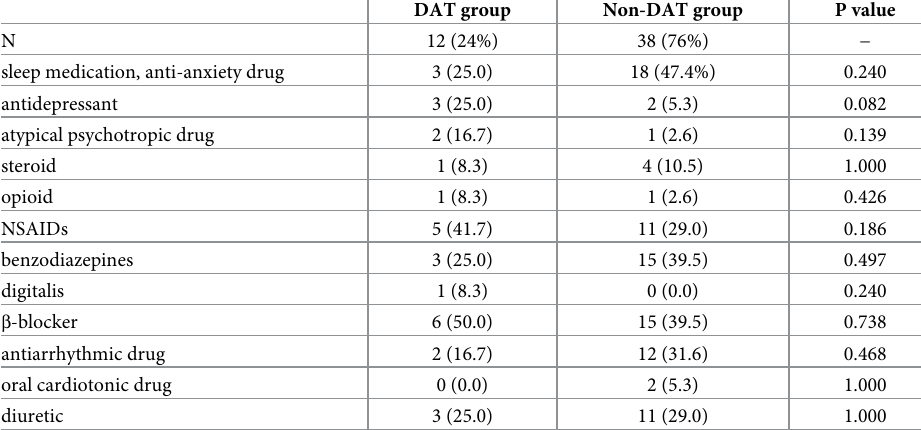
Table 2. Preoperative drug use.